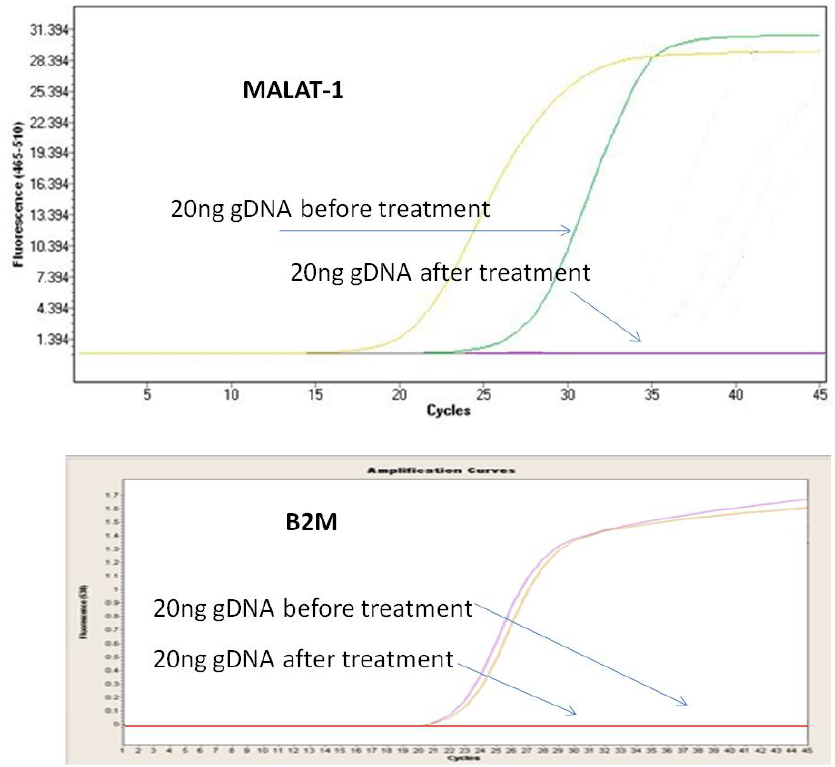
Figure 2. B2M and MALAT1 expression before and after DNase treatment.